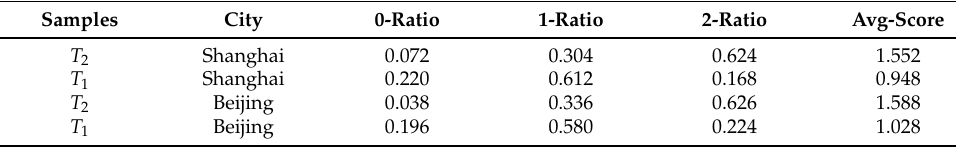
Table 2. Human evaluation of data quality of sampling test